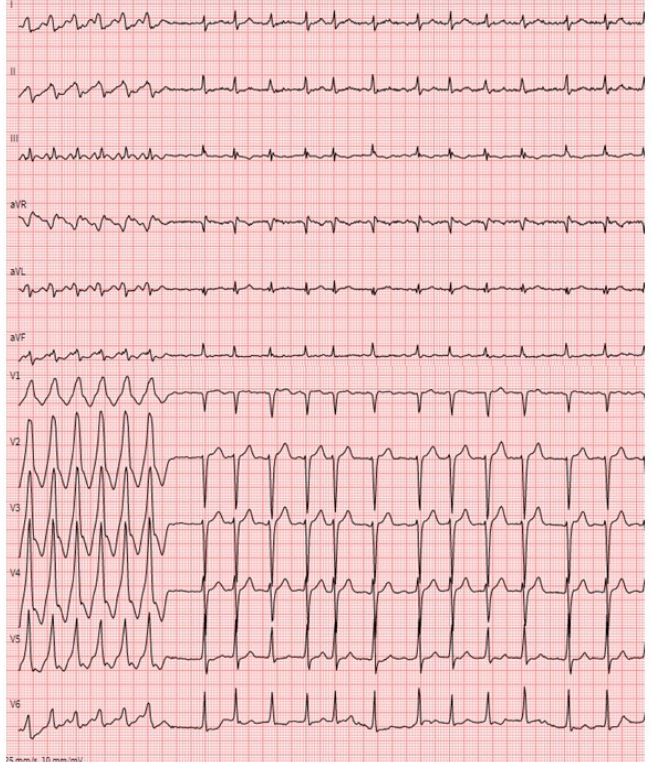
Figure 5. 12-lead surface ECG of a 67-year-old male patient with wtATTR showing a monomorphic VT, which spontaneously terminates into atrial fi brillation.